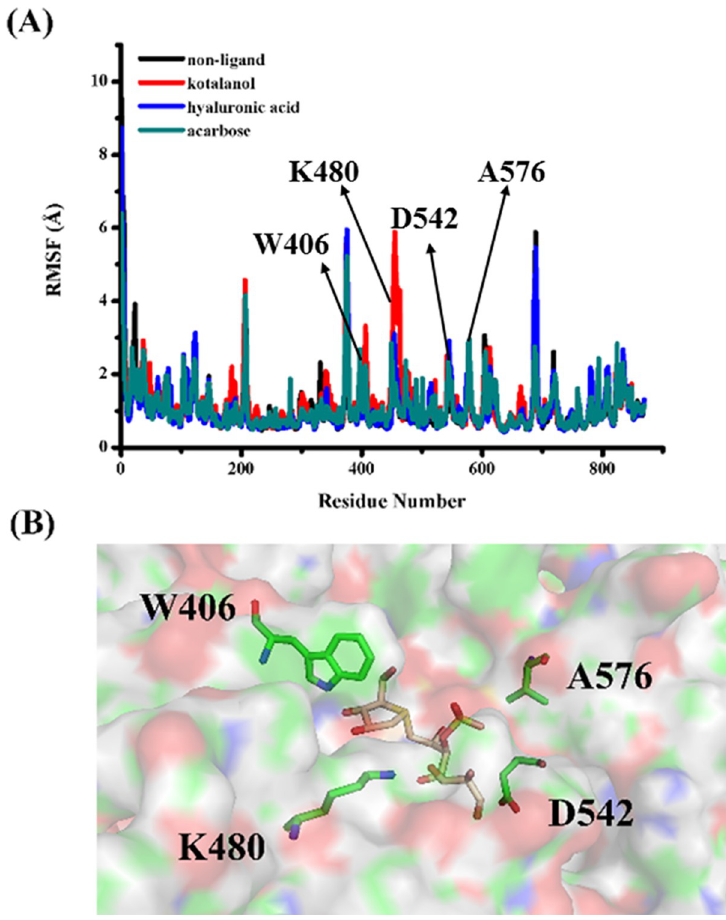
Fig 4. (A) RMSF plot during MD simulations. (B) the active residues for inhibitors